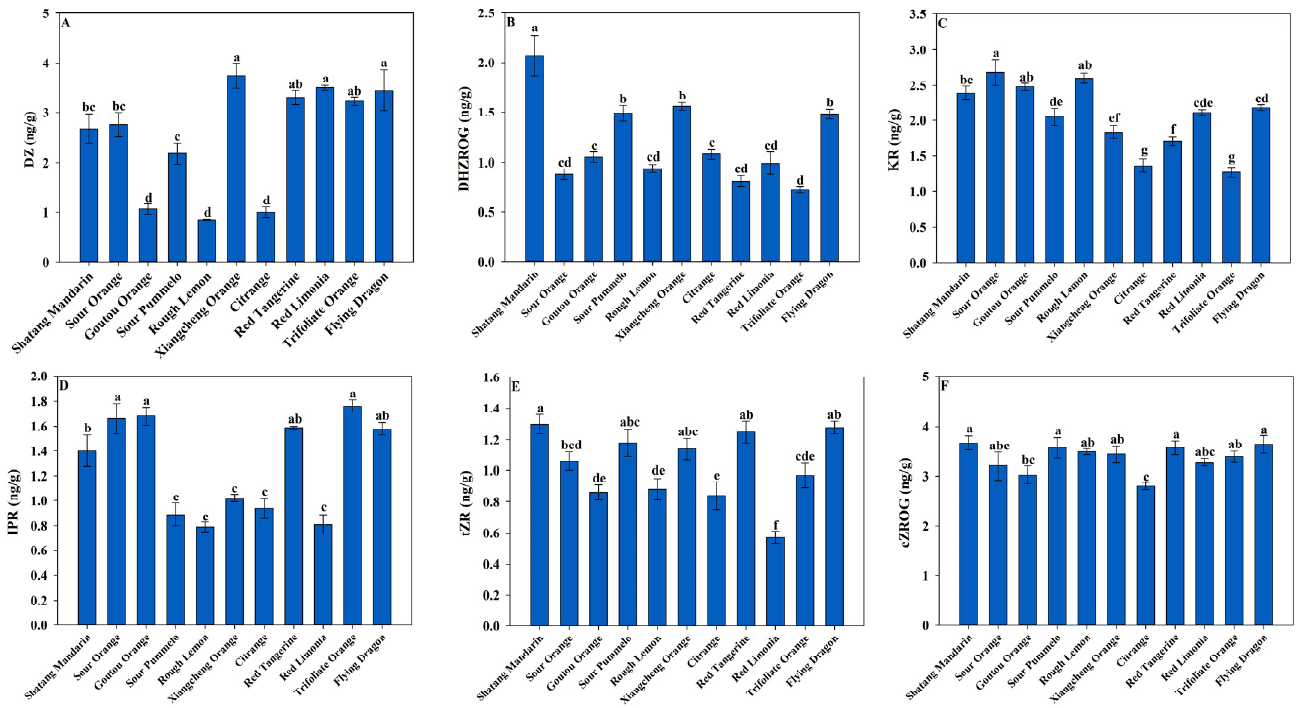
Figure 4. Endogenous cytokinin concentrations in leaf tissues of ‘Shatangju’ scion cultivar grafted onto different rootstocks. DZ = dihydrozeatin ( A ), DHZROG = dihydrozeatin-O-glucoside riboside ( B ), KR = Kinetin riboside ( C ), IPR = Isopentenyl adenine riboside ( D ), tZR = Trans-zeatin riboside ( E ), cZROG = cis-zeatin-O-glucoside riboside ( F ). Error bars indicate the standard error of three biological replicates, and lowercase letters indicate significant differences between rootstocks by LSD ( p ≤ 0.05).